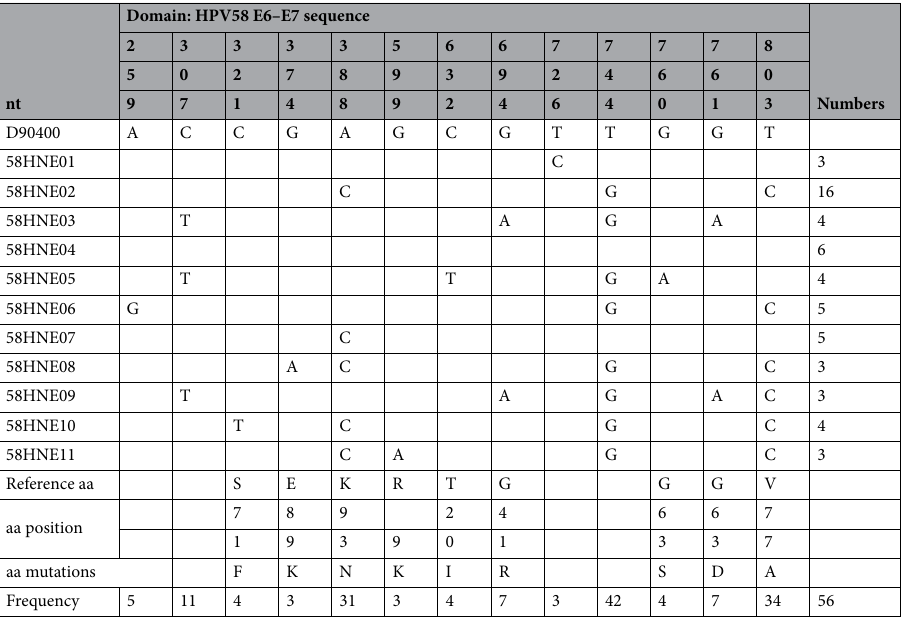
Table 5. Nucleotide sequence mutations of HPV58 E6-E7 genes. Positions without variants are marked with blank, whereas positions with variants are indicated by a